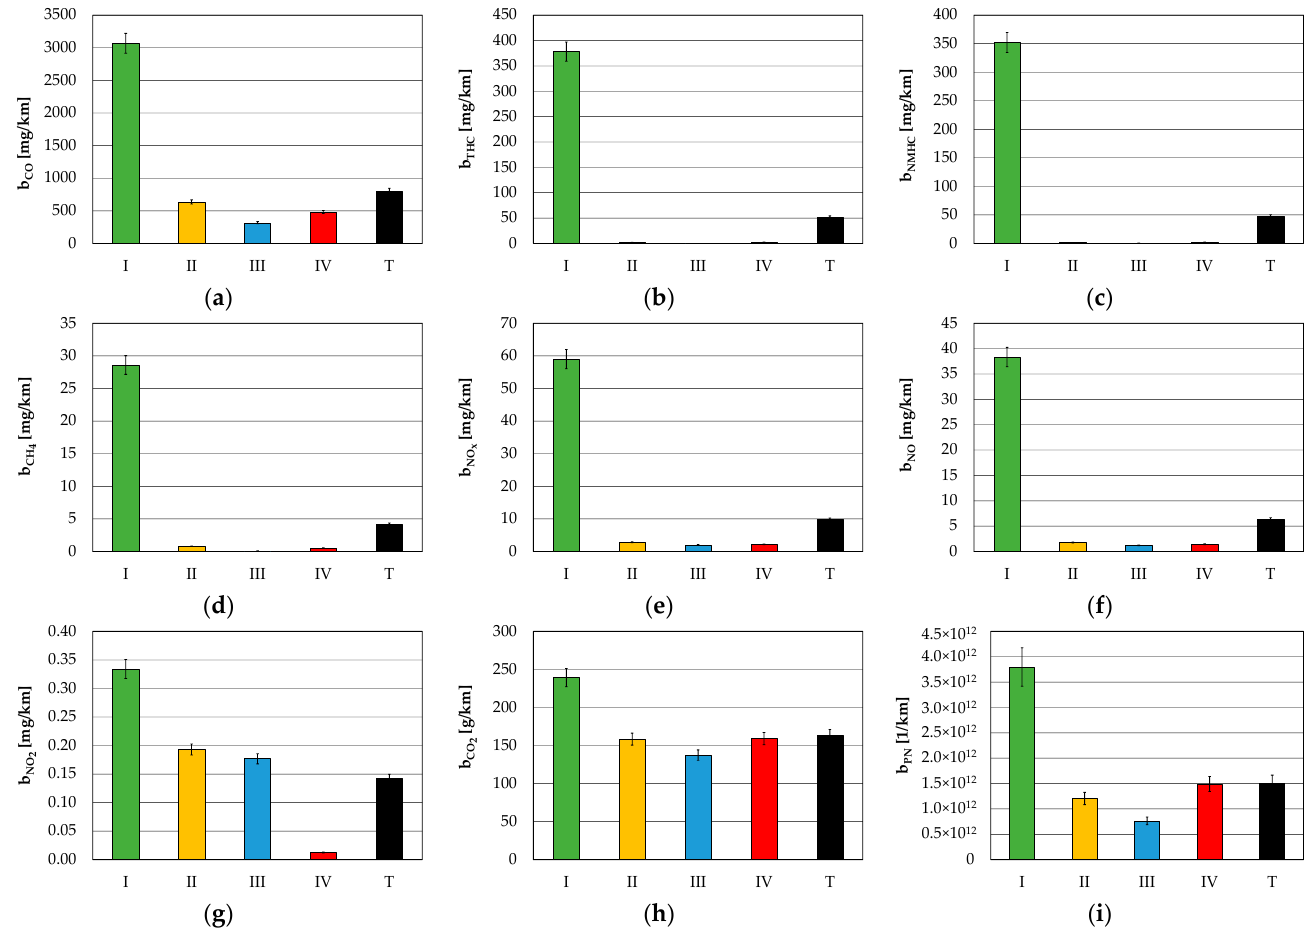
Figure 2. Mean road exhaust emissions in the different phases of the WLTC test (I–Low, II–Medium, III–High, IV–Extra High, T–Total) for: ( a ) carbon monoxide; ( b ) hydrocarbons; ( c ) non-methane hydrocarbons; ( d ) methane; ( e ) nitrogen oxides; ( f ) nitrogen oxide; ( g ) nitrogen dioxide; ( h ) carbon dioxide; ( i ) number of emitted particles.